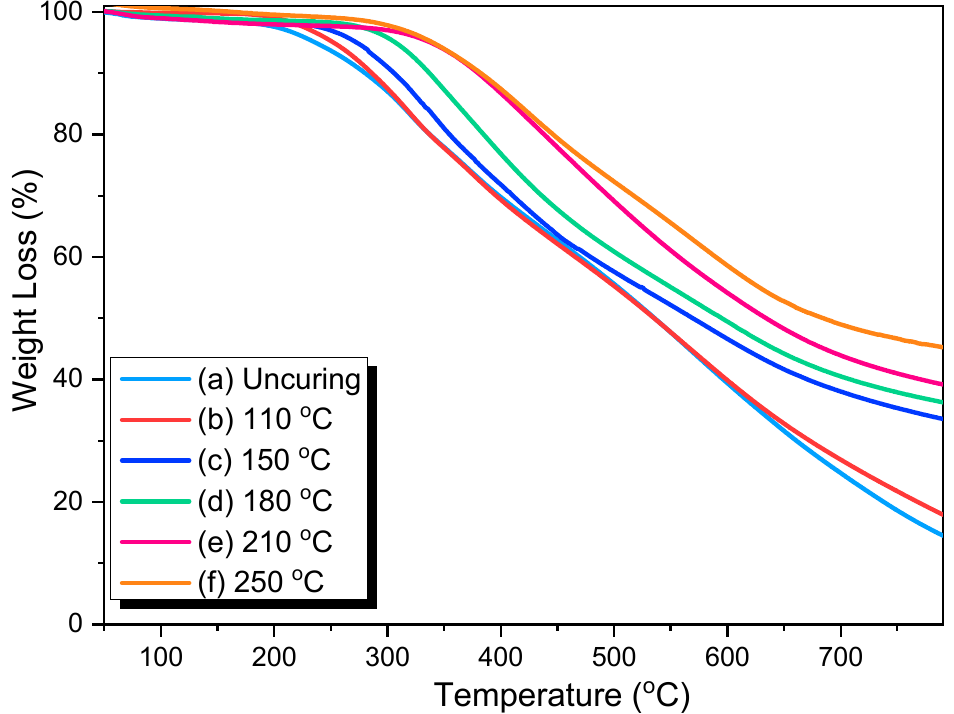
Figure 3. TGA analyses of the uncured PA-BZ and the PA-BZ cured at various